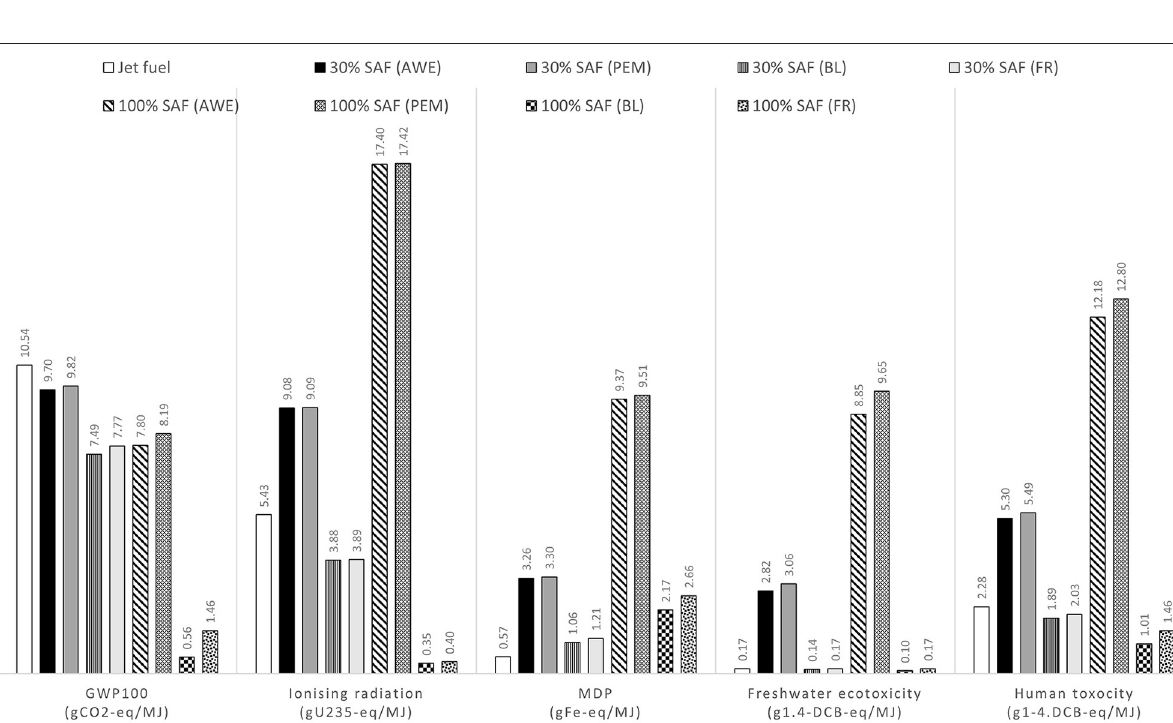
Frontiers in Sustainability |